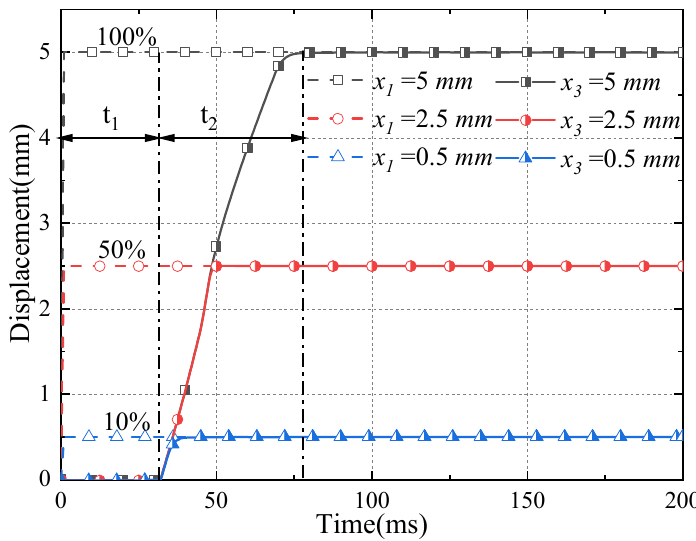
Figure 12. The step response of the proportional valve. Figure 13. First, the pressure rises to 0.5 MPa, and the main outlet valve moves to the